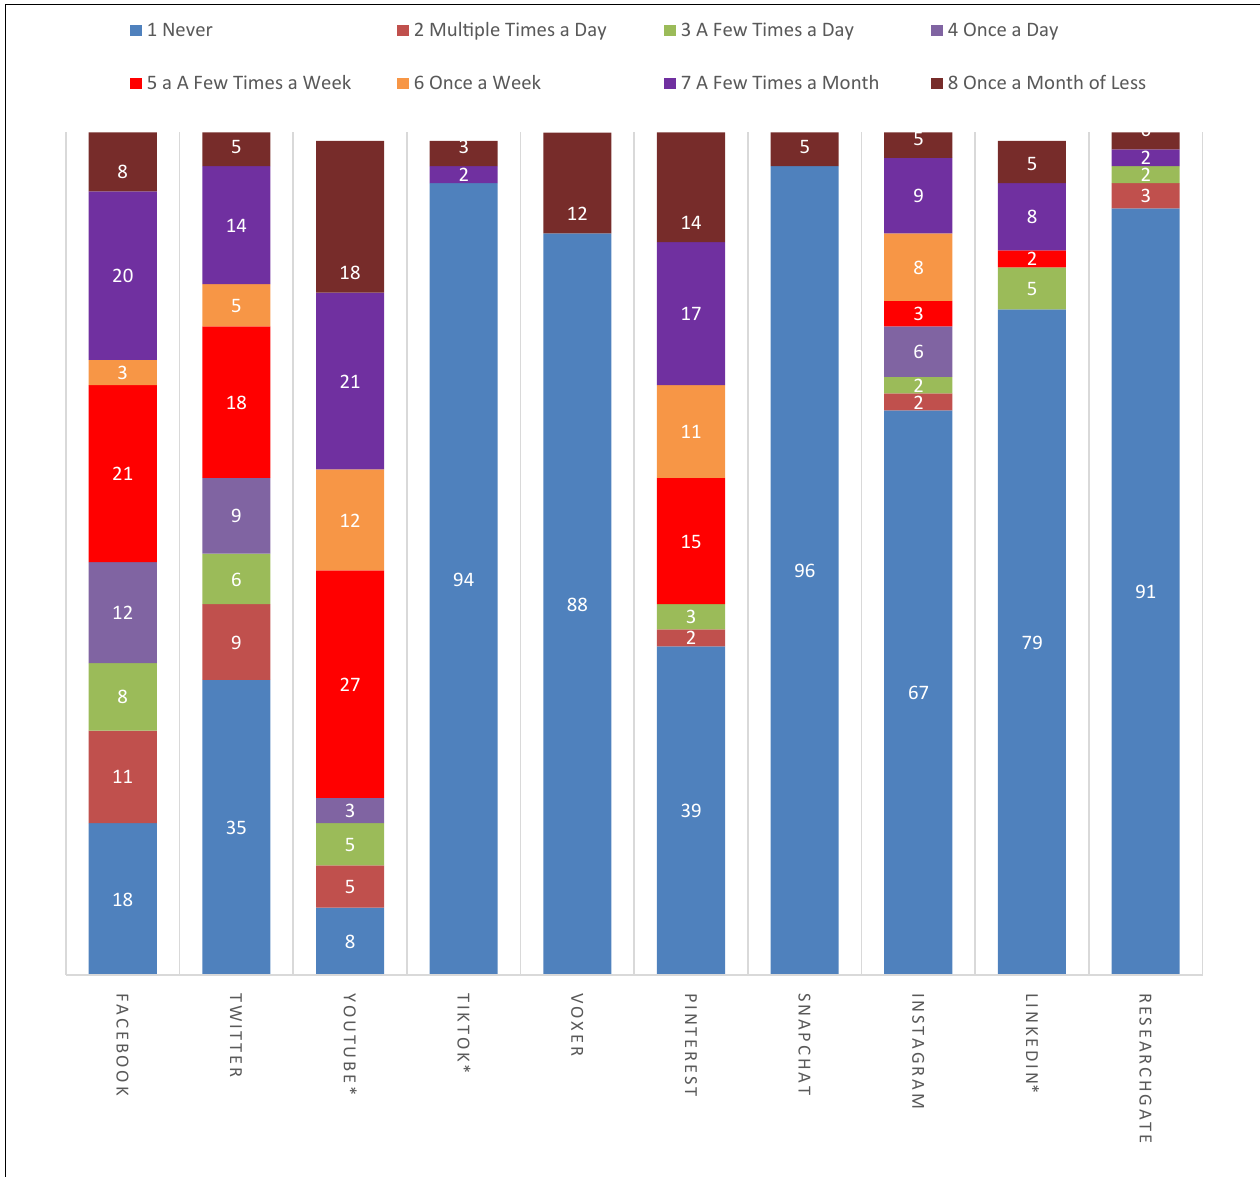
FIGURE 1 | Frequency percentages of social media platforms used. ∗ Indicates missing data.